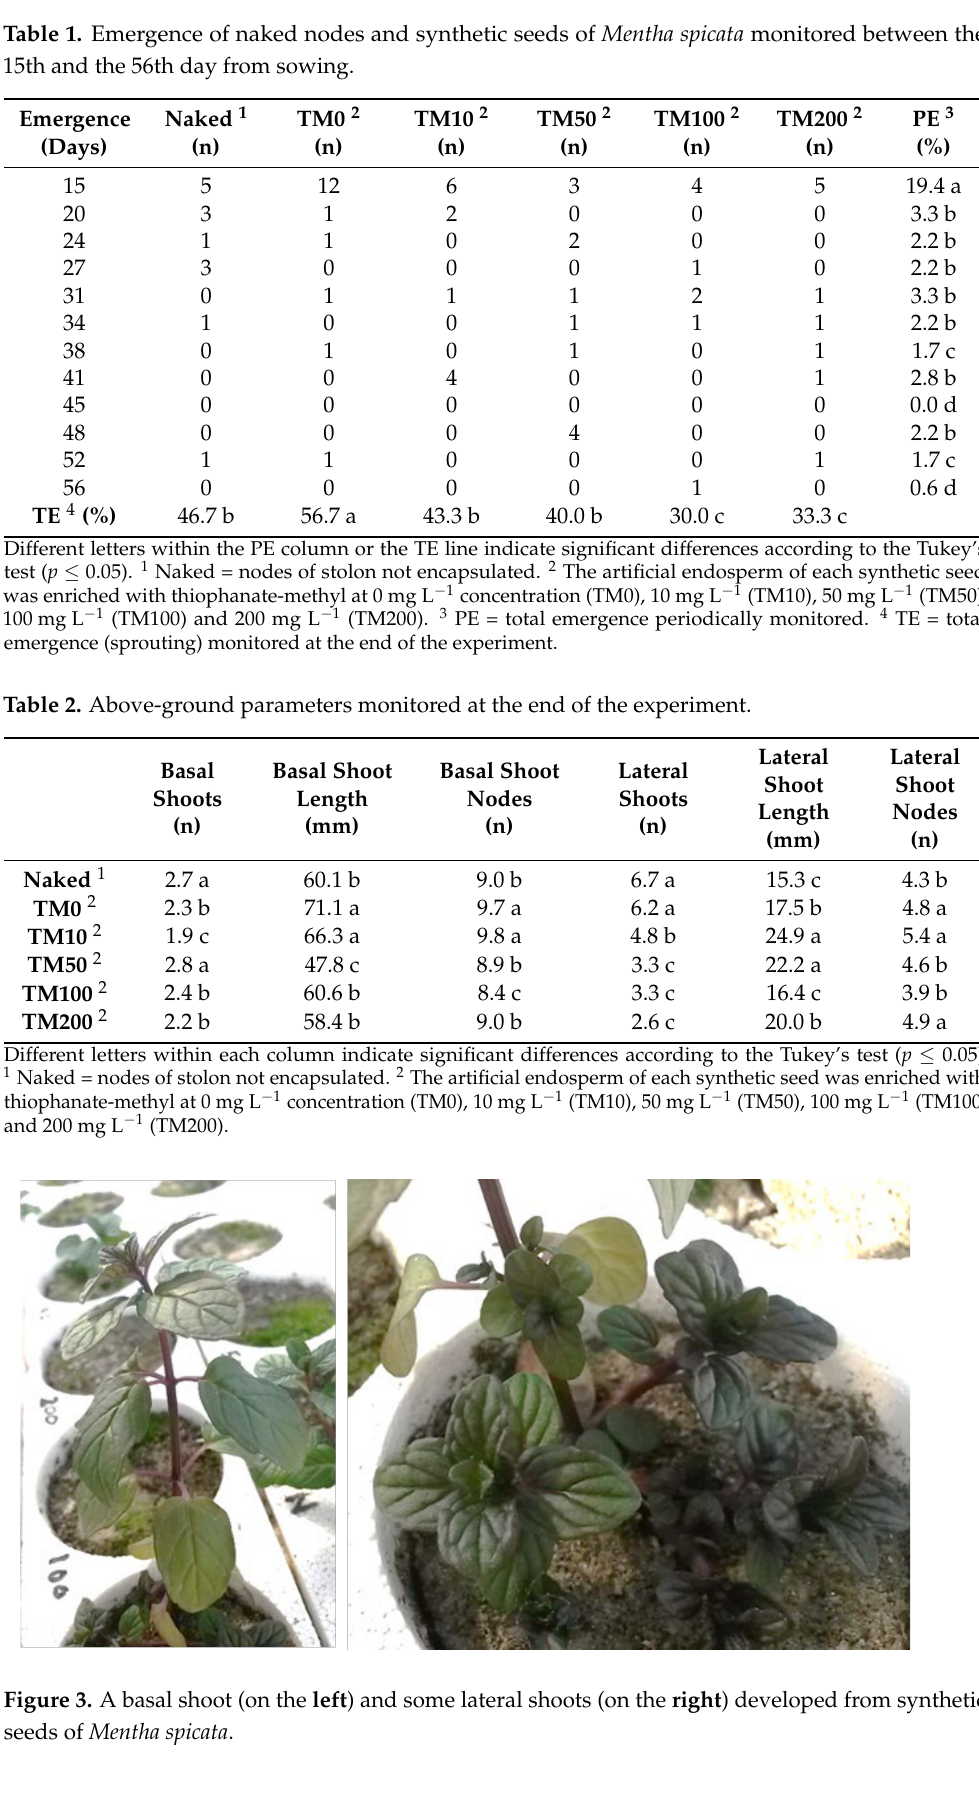
Figure 3. A basal shoot (on the left ) and some lateral shoots (on the right ) developed from synthetic seeds of Mentha spicata .